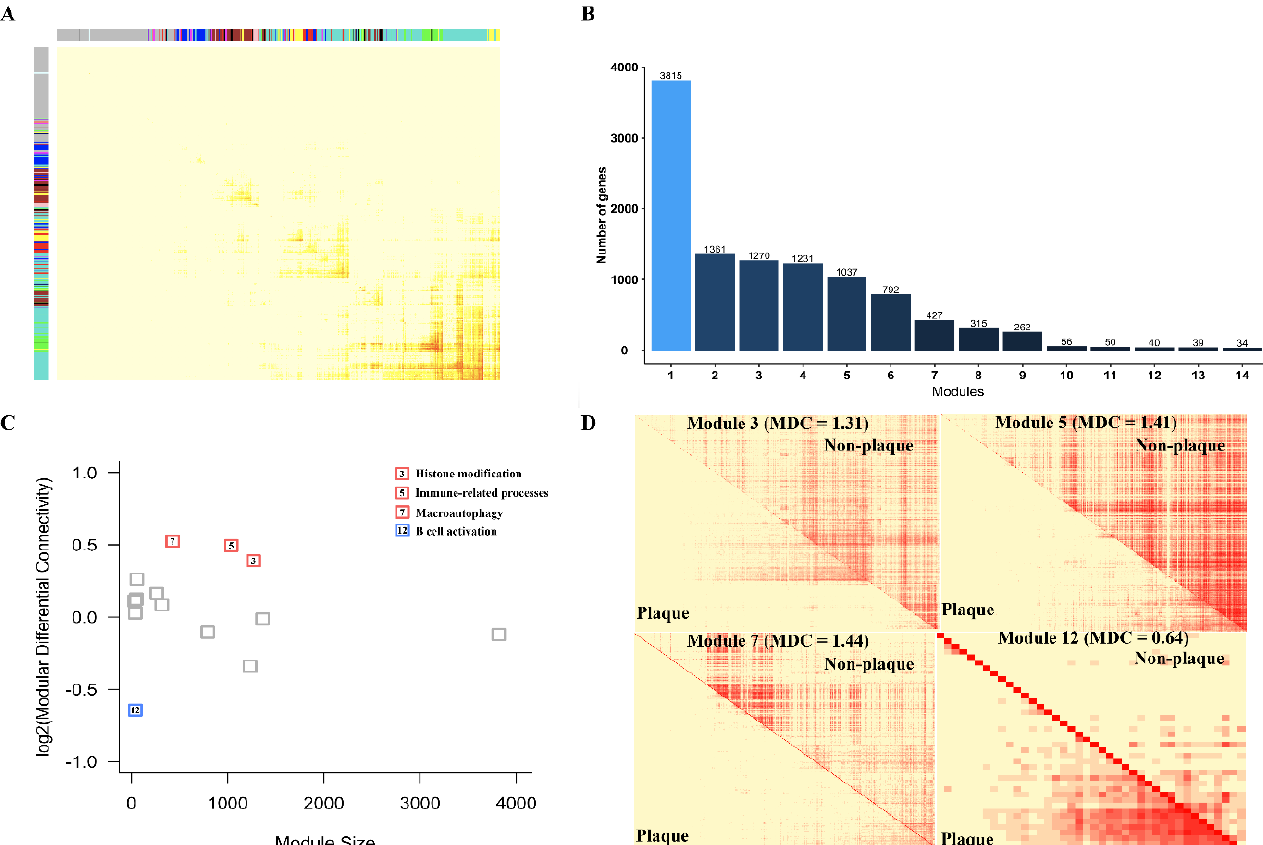
Figure 3. Differential modular connectivity analyses for individual genes in non-plaque and plaque stages. ( A ) Gene co-expression network module in different stages of atherosclerotic plaque. The rows and columns represent the same set of 14,256 genes with the first 75% variance in the dataset of GSE43292. ( B ) The numbers of modules and genes in weighted gene co-expression network modules based on the dataset of GSE43292. ( C ) Differential connectivity modules are highlighted. The y − axis represents the log2 transformed modular differential connectivity values. The x − axis denotes the number of genes in the corresponding modules. ( D ) Heatmap of gene-gene correlation in the differential connectivity of modules in the non-plaque stage (the upper right triangle of each module) compared with that in the plaque stage (the lower left triangle of each